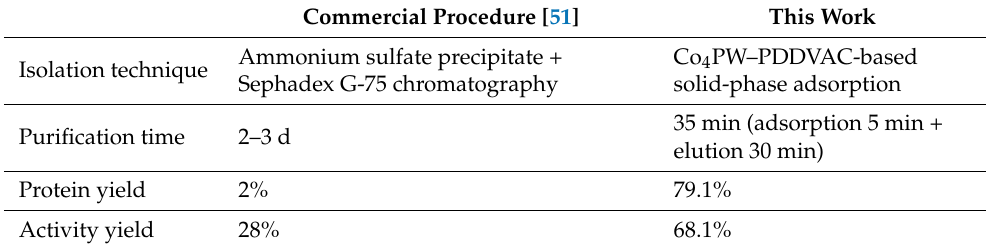
Table 4. Comparisons of the performance of PrK isolation